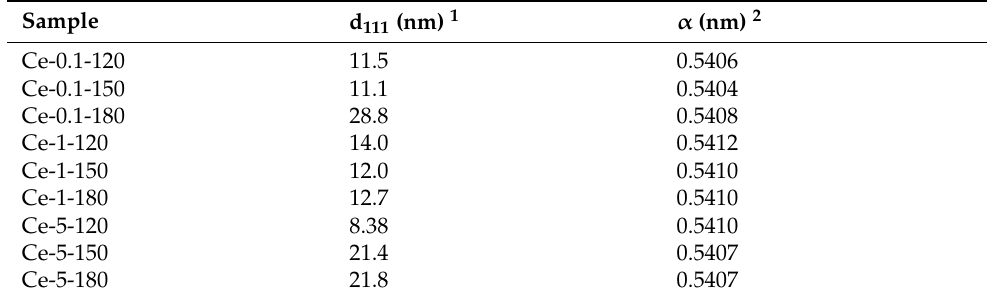
Figure 3. XRD patterns of hydrothermally prepared pure ceria ( a ) and CuCe oxide ( b ) samples. Table 2. Average crystallite size (d 111 ) and lattice parameters ( a ) of pure ceria samples based on the crystal plane of (111) of CeO 2 .